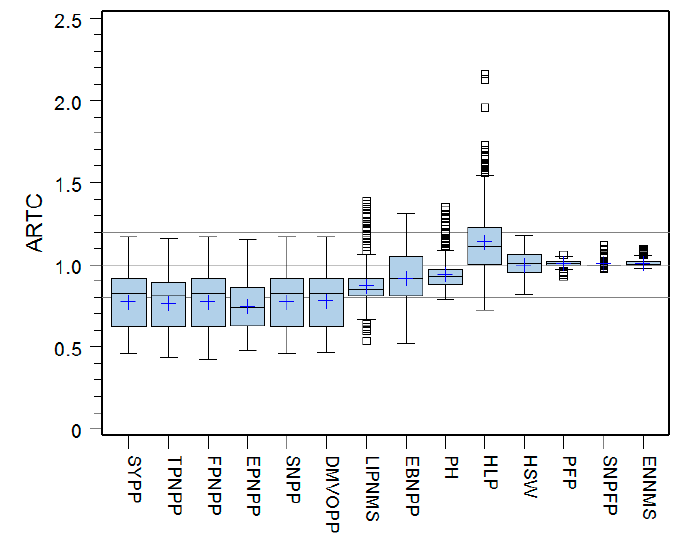
Figure 2. Boxplots of ARTC s (acid rain tolerance coefficients) of the 14 traits potentially related to AR tolerance for the tested soybean population. SYPP, Seed yield per plant; TPNPP, Total pod number per plant; FPNPP, Fruited pod number per plant; EPNPP, Empty pod number per plant; SNPP, Seed number per plant; DMVOPP, Dry matter in vegetative organs per plant; LIPNMS, Length of interval for the podding nodes on the main stem; EBNPP, Effective branch number per plant; PH, Plant height; HLP, Height of the lowest pod; HSW, Hundred seed weight; PFP, Percent of fruited pod; SNPFP, Seed number per fruited pod; ENNMS, Effective node number on the main stem.